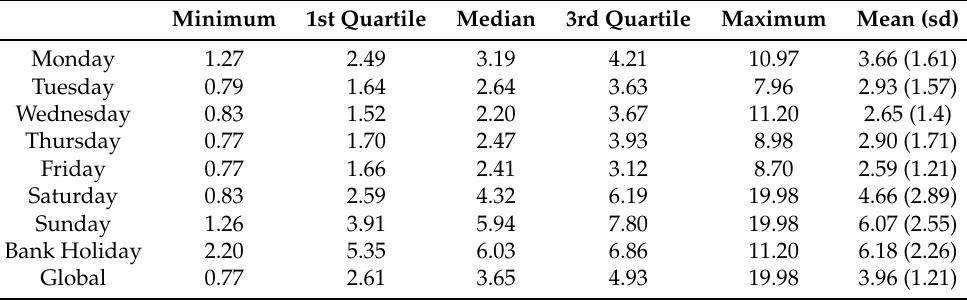
Table 9. Daily MAPE (in %) on prediction for the FSSM forecasting.